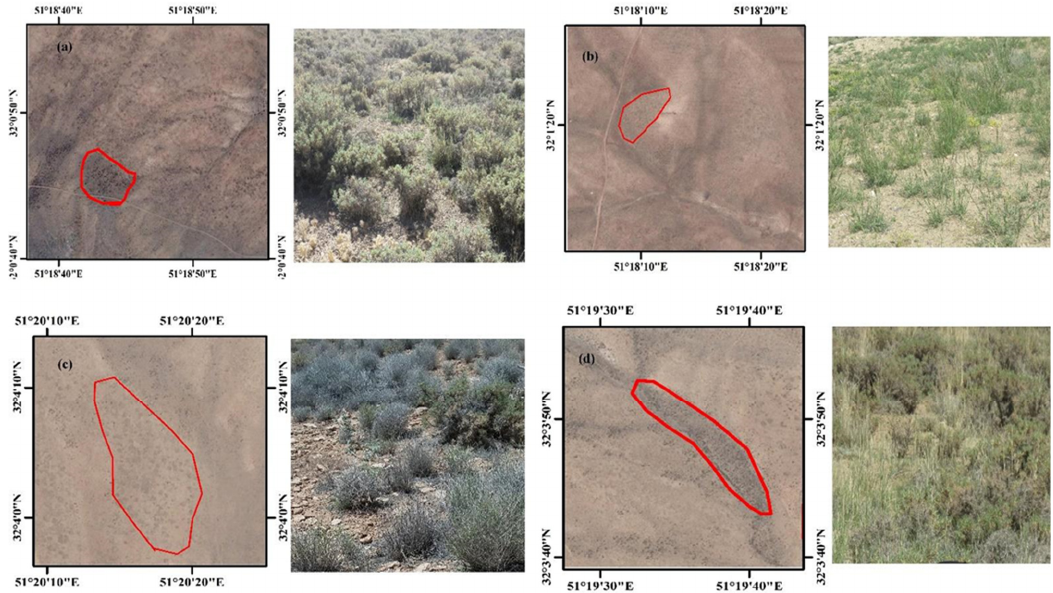
Figure 2. The location of VTs in Google Earth images and the corresponding field photos. ( a )—VT1 (As ve); ( b )—VT2 (Br to); ( c )—VT3 (Sc or); and ( d )—VT4 (As ve-Br to).